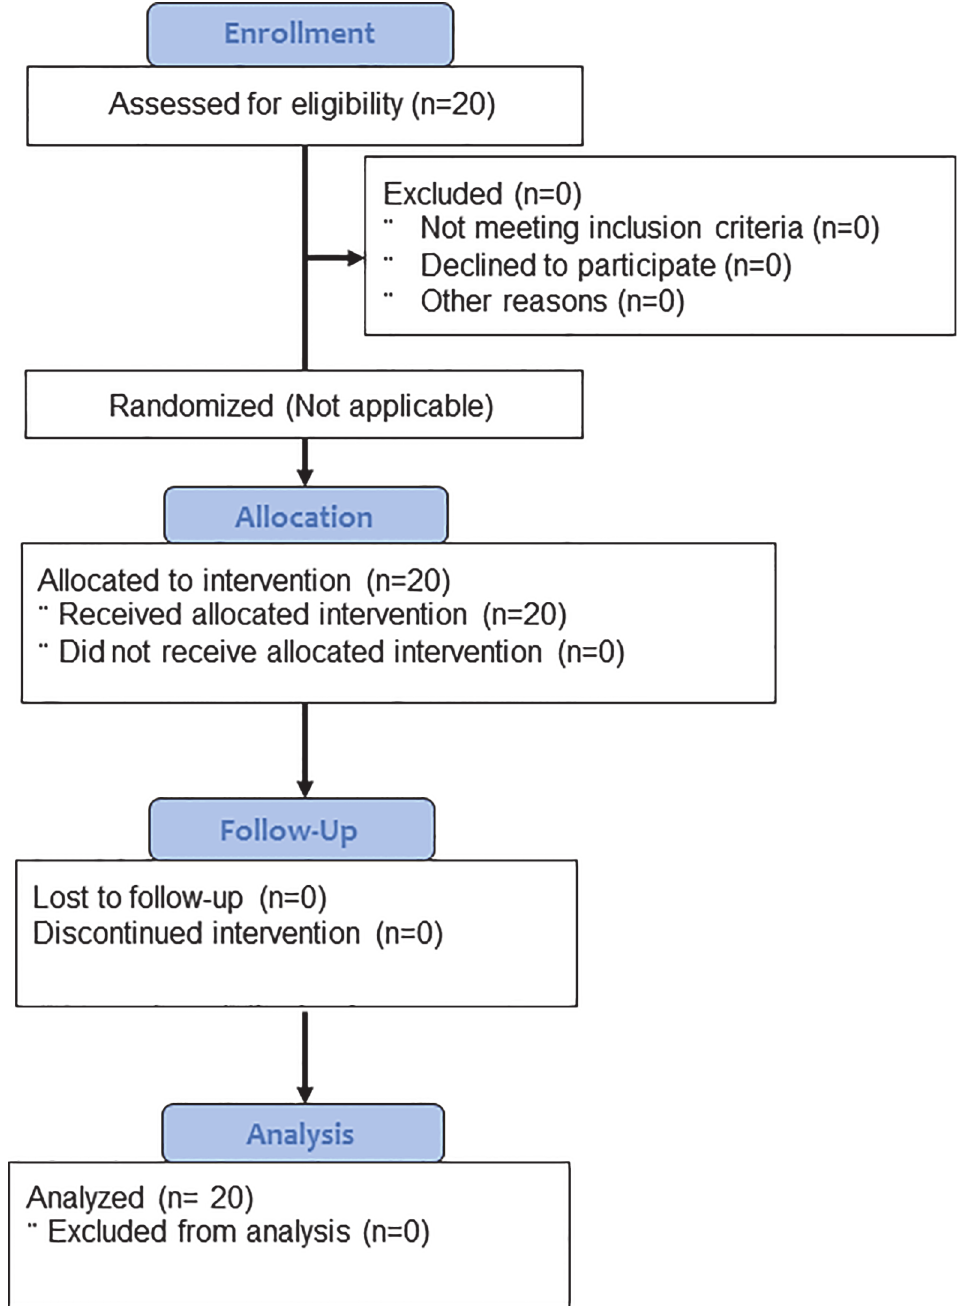
Fig 1. CONSORT flow diagram for single dose PK study of Cogni.Q pyranocoumarins.